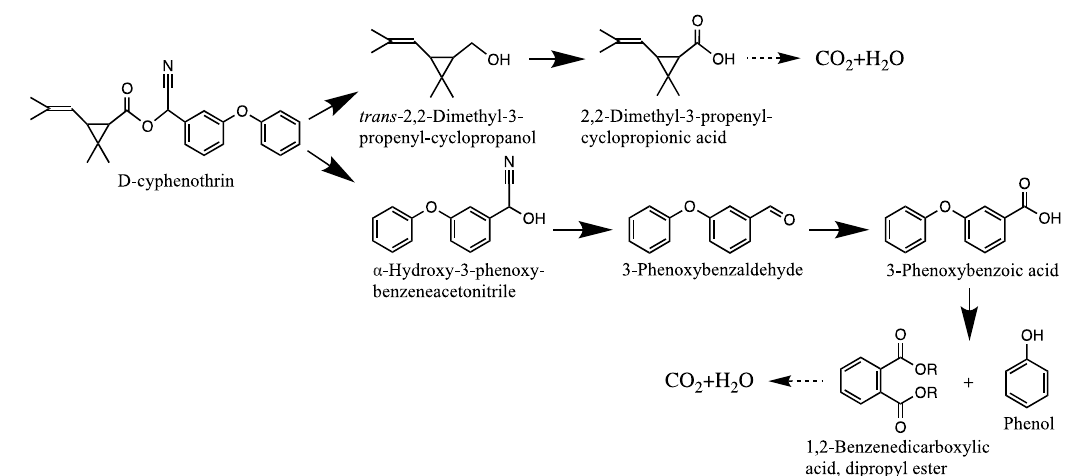
Figure 4. Proposed D-cyphenothrin degradation pathway in Staphylococcus succinus HLJ-10.